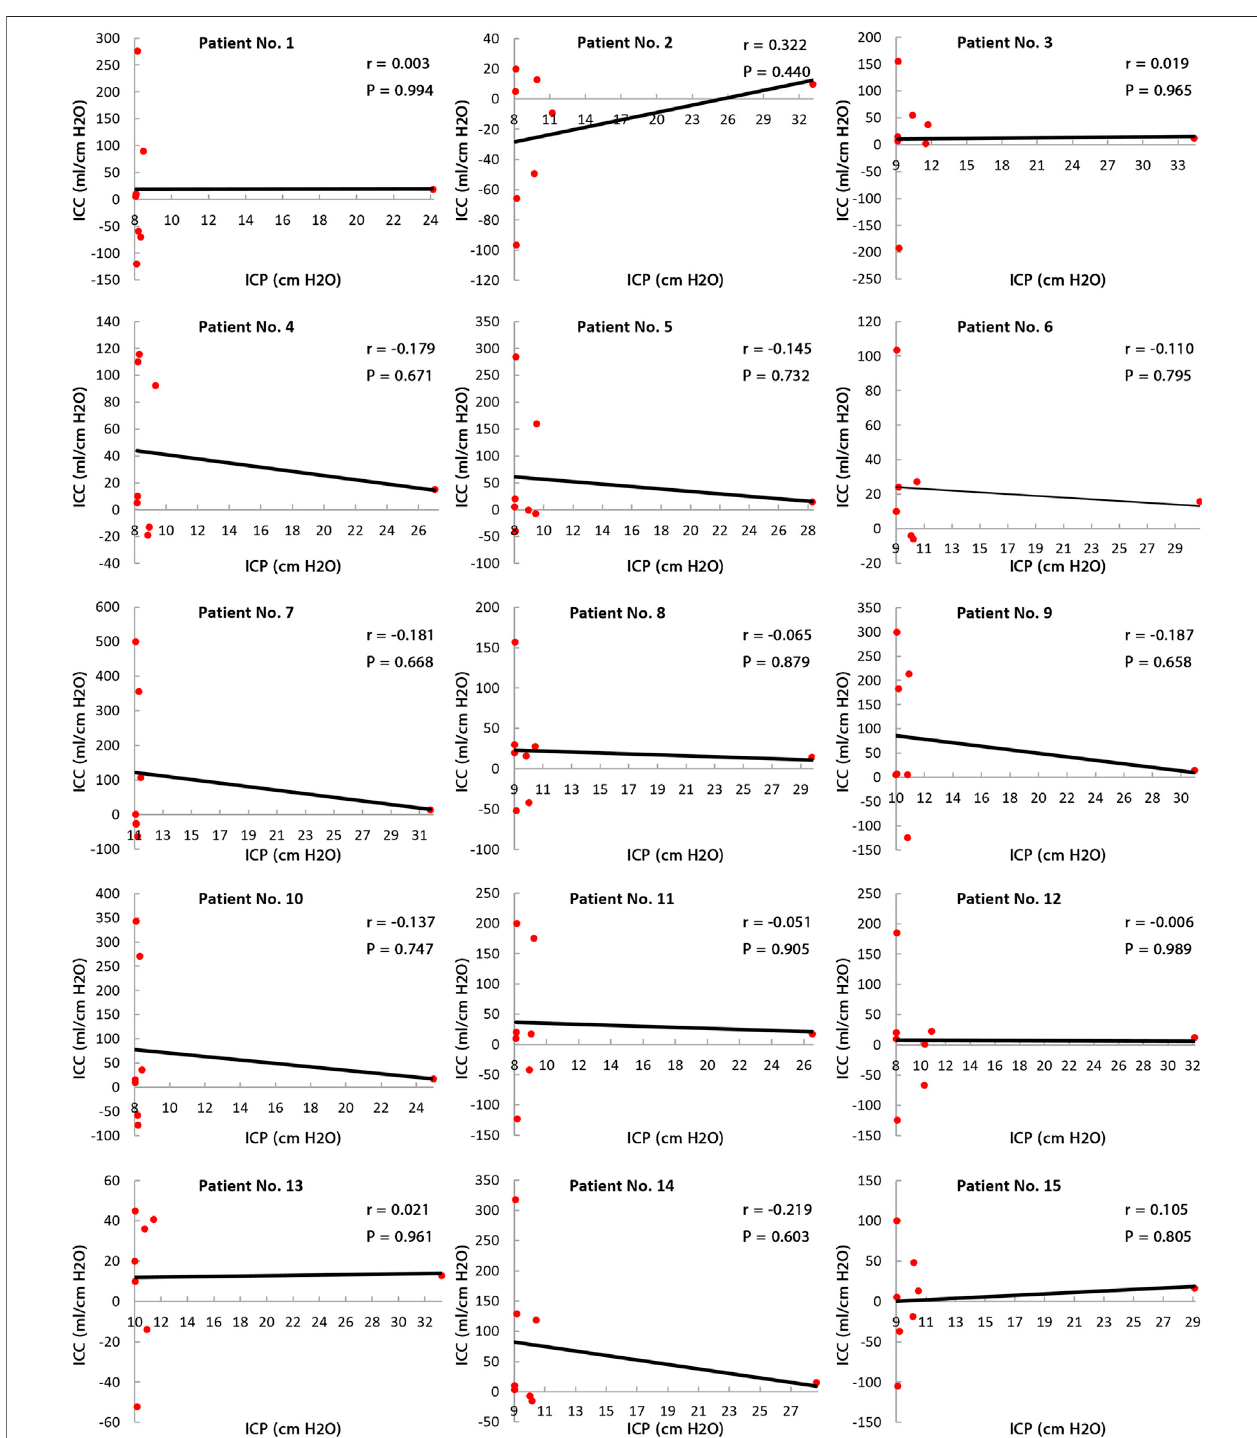
FIGURE 7 | Relationship between long-term ICC and ICP. Pearson ’ s correlation results between long-term ICC and ICP in all 15 patients show that all ps are greater than 0.44, so the correlations are not statistically “ signi fi cant. ” This means there is no linear relationship between long-term ICC and ICP. Raw data for Figure 6 are included in Supplementary Tables S3 and S4 . ICP: intracranial pressure; and ICC: intracranial compliance.